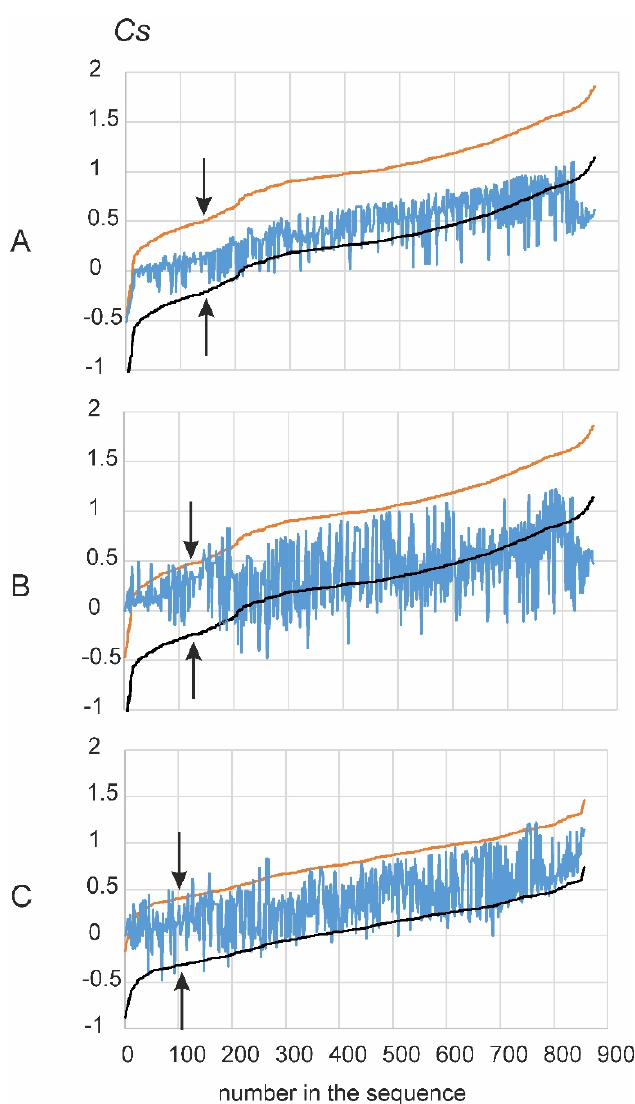
Figure A3. 10% confidence interval for skewness (according to 2-sigma T -test, shown by arrows) for the sequences of annual maximum snow pack depth H s during the years 1985–2019 with trend ( A ); during the years 1985–2019 with linear trend excluded ( B ) and during the years 1985–2013 with linear trend excluded ( C ). The blue lines show the variation in skewness of sequences.